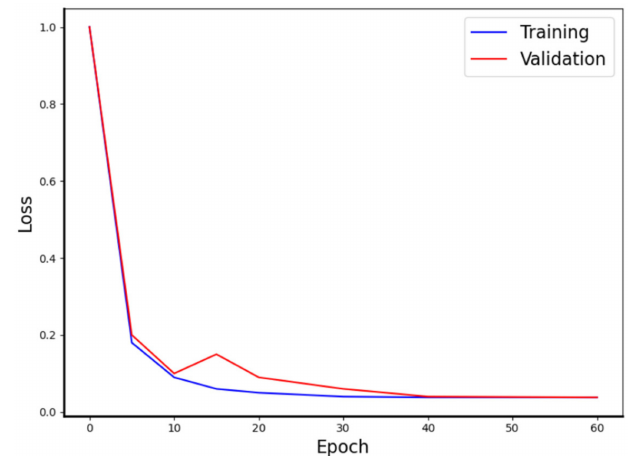
Figure 5. The training and validation loss of the model’s training.